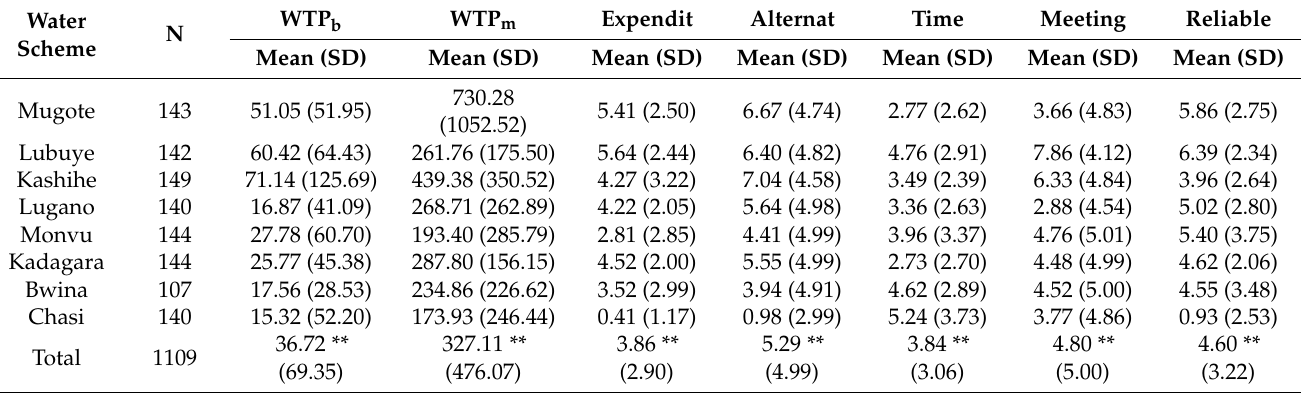
Table 6. Mean values of WTP b , WTP m and predictor